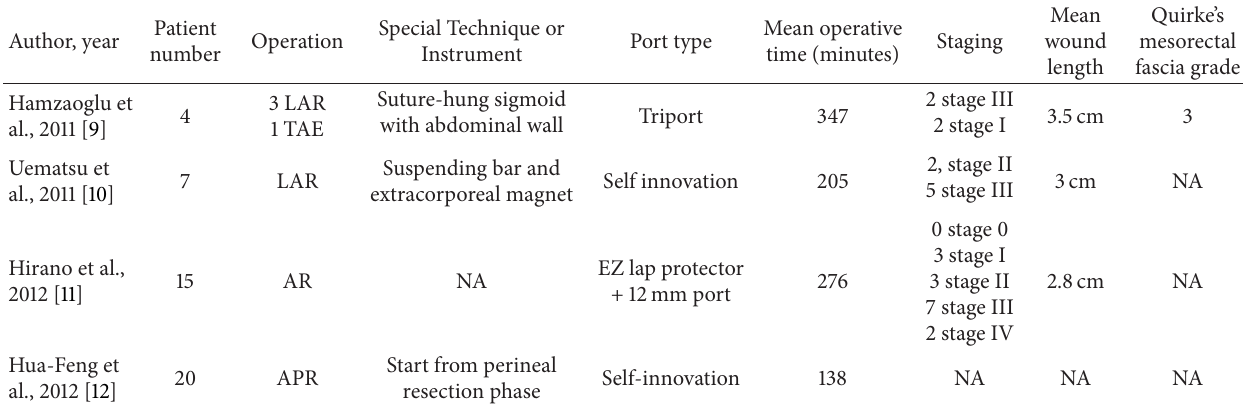
Table 4: Previous results in Single access rectal cancer surgery.